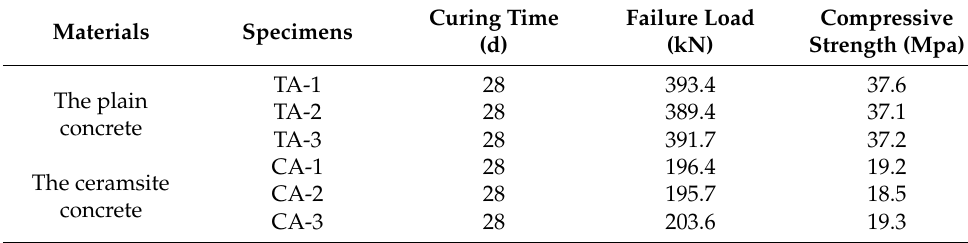
Table 2. Compressive test results.